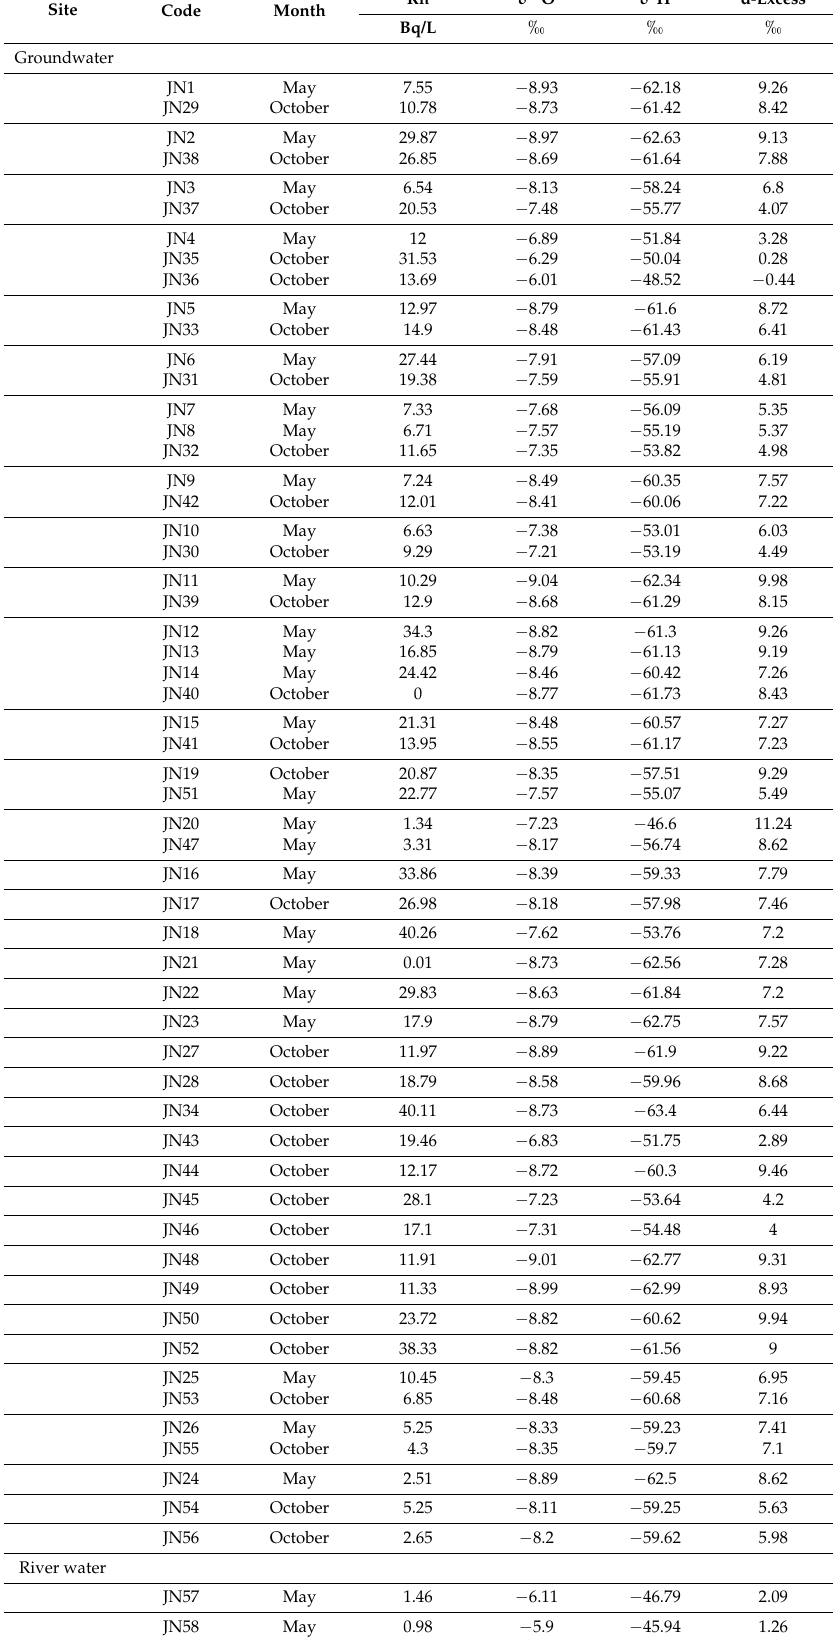
Table 2. Isotope data of the water samples in